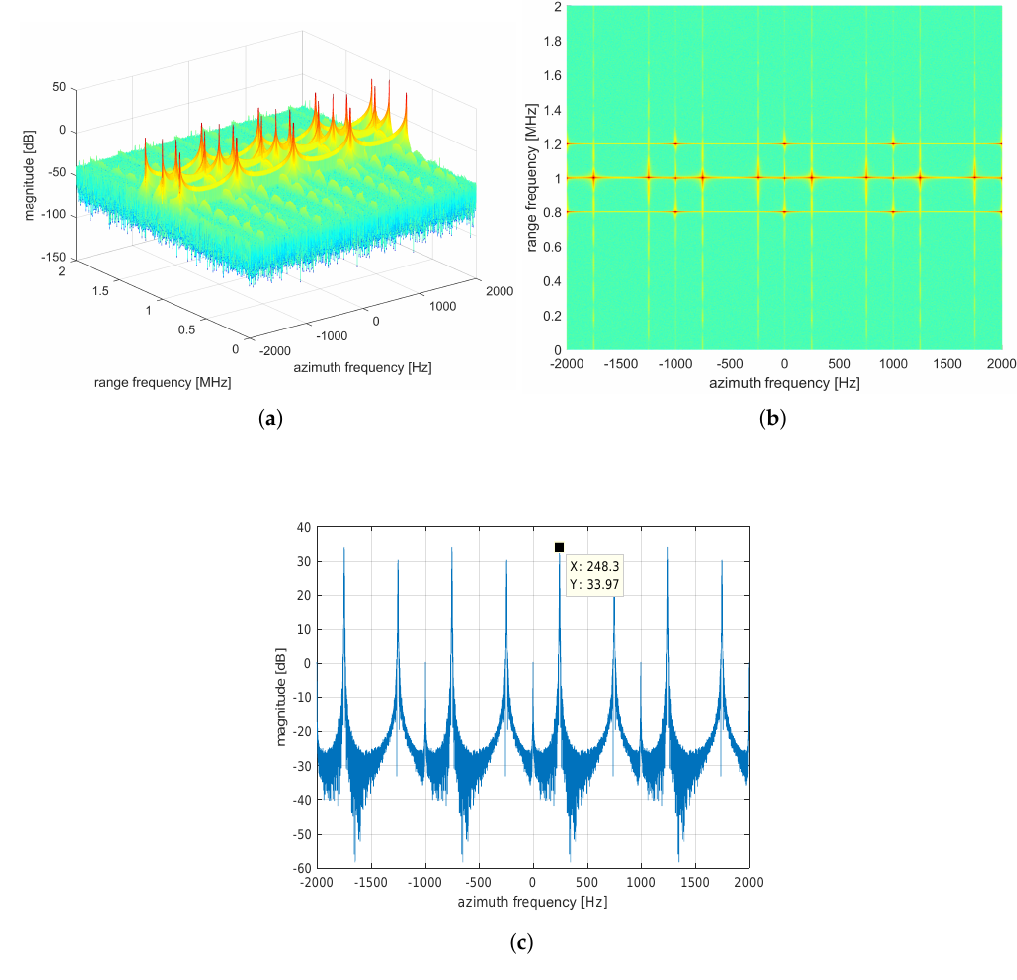
Figure 18. Simulation results before MCRA: ( a ) three-dimensional plot; ( b ) two-dimensional plot; ( c ) azimuth frequency cut at Scatterer